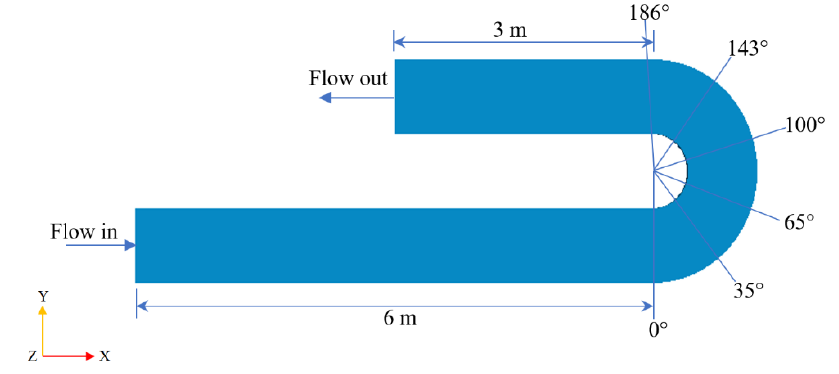
Figure 3. Rozovskii’s experimental data [14]. Figure 3 . Rozovskii’s experimental data [14] . Table 1. The flow conditions and dimensions of the curved channel [13]. Table 1. The flow conditions and dimensions of the curved channel [13] .